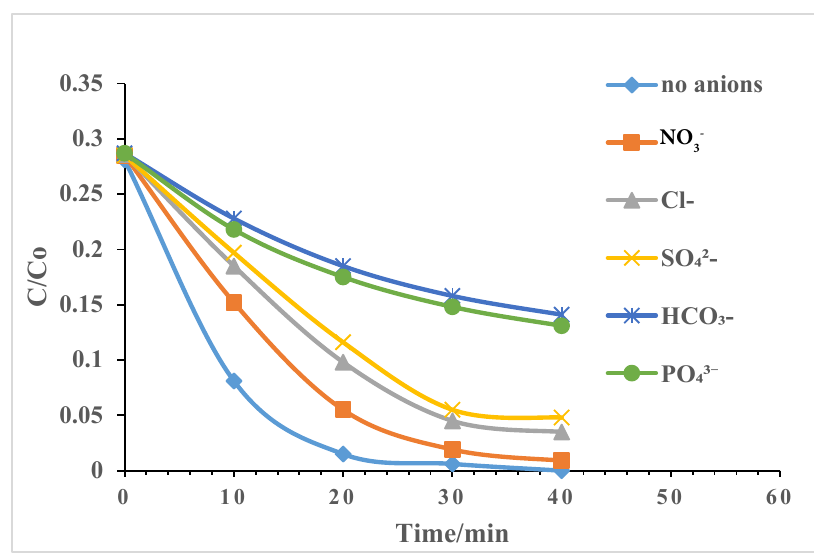
Fig. 10. Effect of Electrolyte for degradation of Orange G dye in presence of FeCr